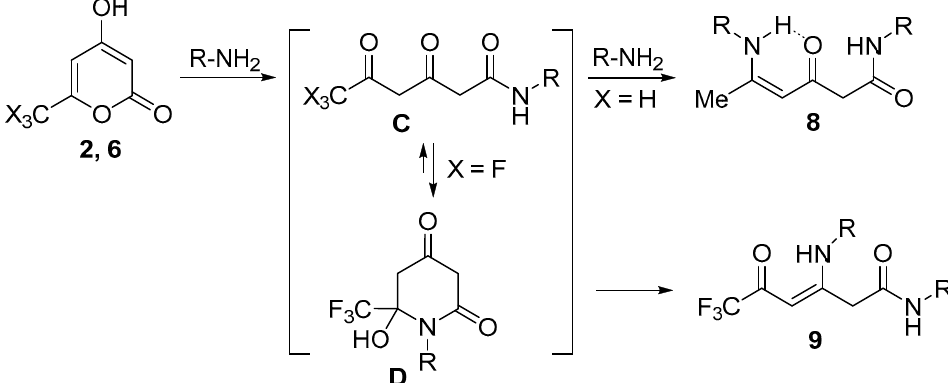
Scheme 8. Proposed mechanism of the reaction of TAL and TAL- f 3 with primary amines.